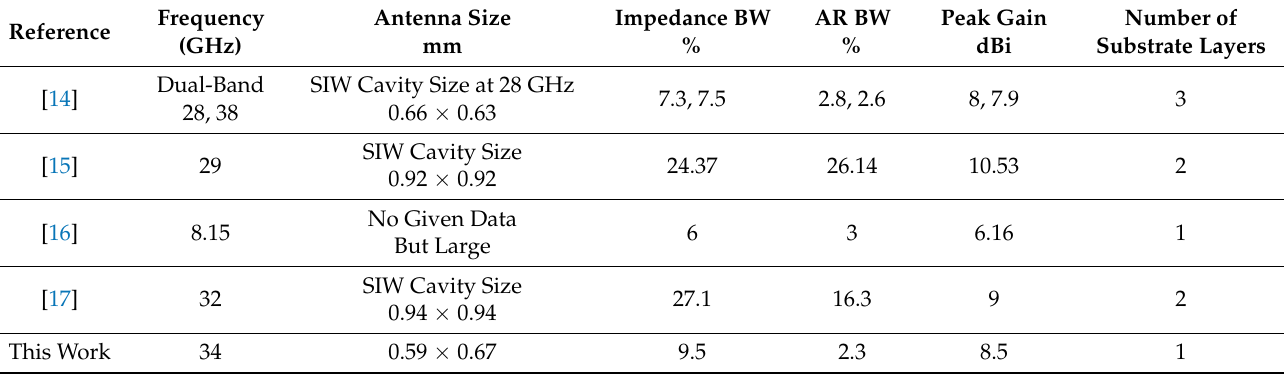
Table 2. Comparison with previously reported cp antenna elements.